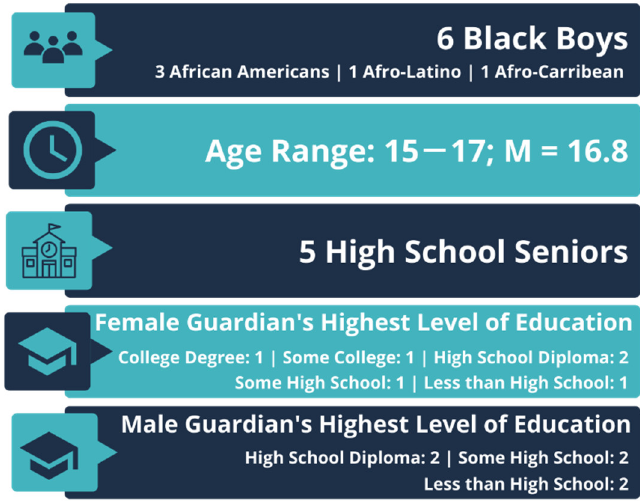
Figure 1. Sample Demographics.